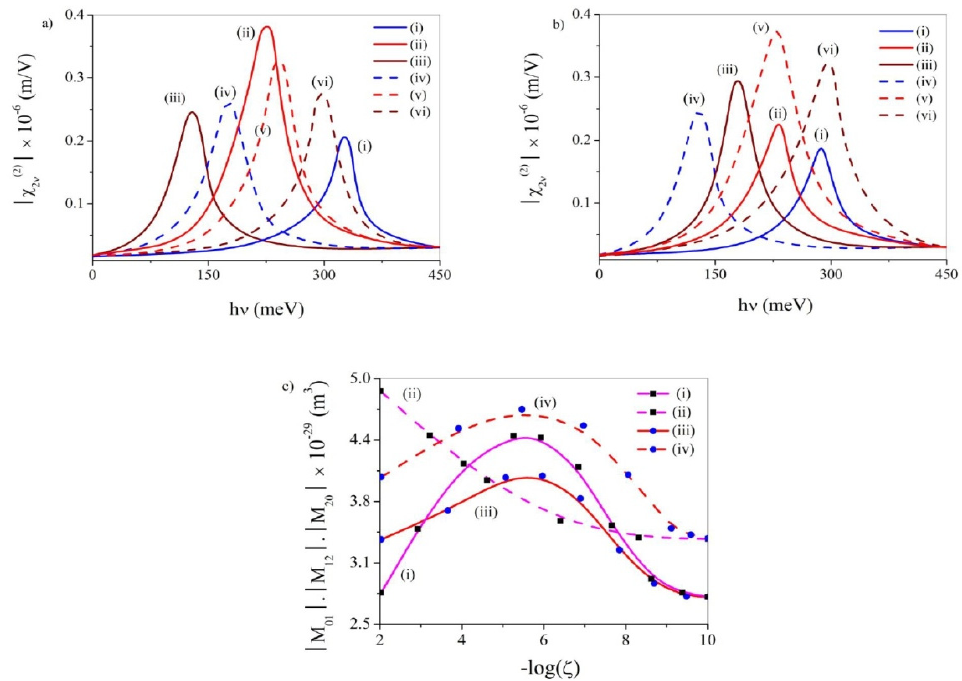
Figure 8. SHG vs. h υ diagrams with ( a ) OPA and ( b ) EPA. In these diagrams (i) ADWN and ζ = 10 − 10 , (ii) ADWN and ζ = 10 − 6 , (iii) ADWN and ζ = 10 − 2 , (iv) MLWN and ζ = 10 − 10 , (v) MLWN and ζ = 10 − 6 , (vi) MLWN and ζ = 10 − 2 . ( c ) Depiction of GF for SHG vs. − log( ζ ): (i) with ADWN and OPA, (ii) with ADWN and EPA, (iii) with MLWN and OPA and (iv) with MLWN and EPA. Under EPA and with applied ADWN the SHG peaks divulge red-shift and monotonic increase of peak height as ζ increases. However, with applied MLWN the said peaks delineate blue-shift as ζ enhances and maximizes at ζ ~10 − 6 .